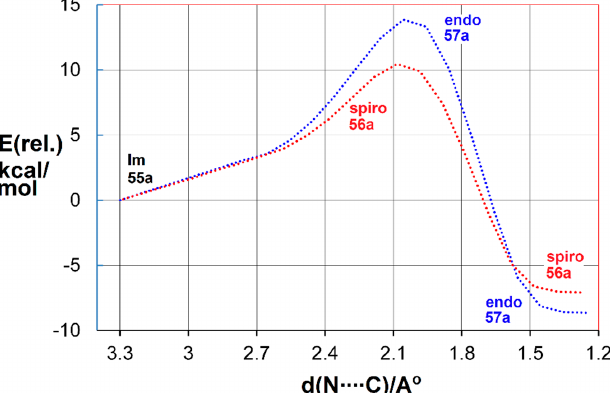
Figure 4. DFT computed reaction coordinates for spiro ( red ) and endo ( blue ) ring closure of benzofuro-iminyl radical 55a .